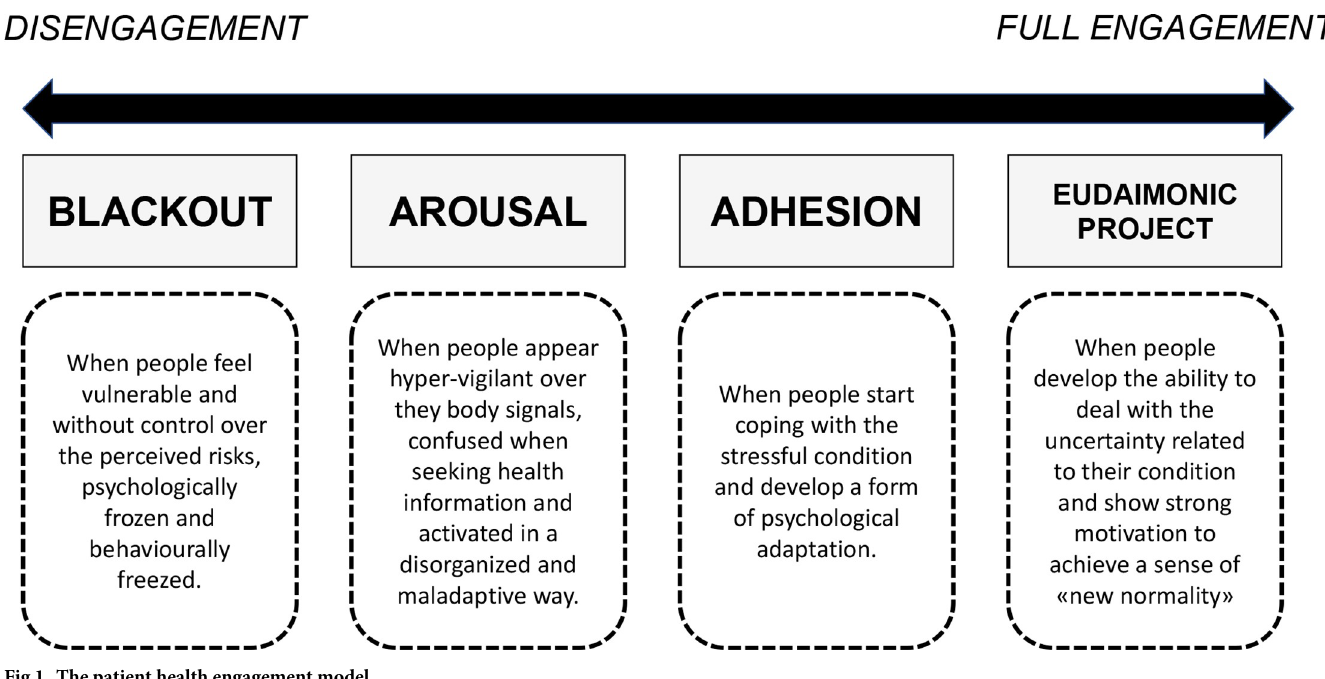
Fig 1. The patient health engagement